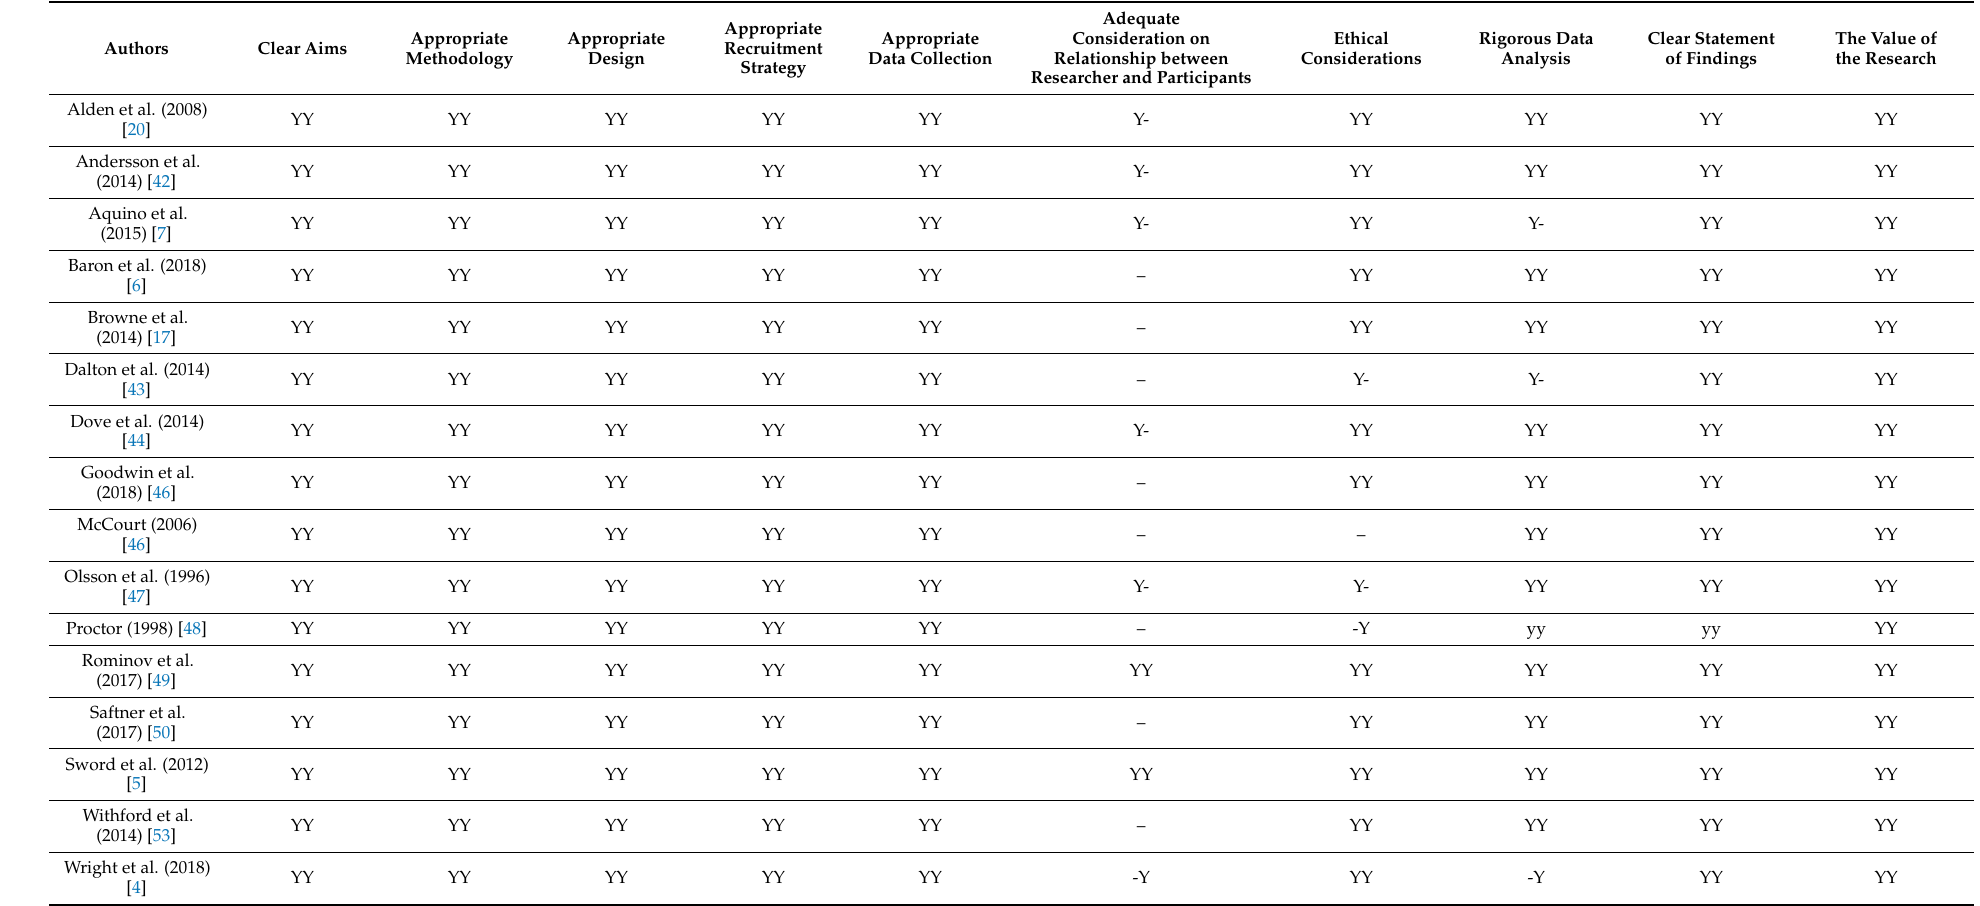
Table 3. Quality assessment of selected studies ( n = 16). (Abbreviations: Y = yes; N = no; - = cannot